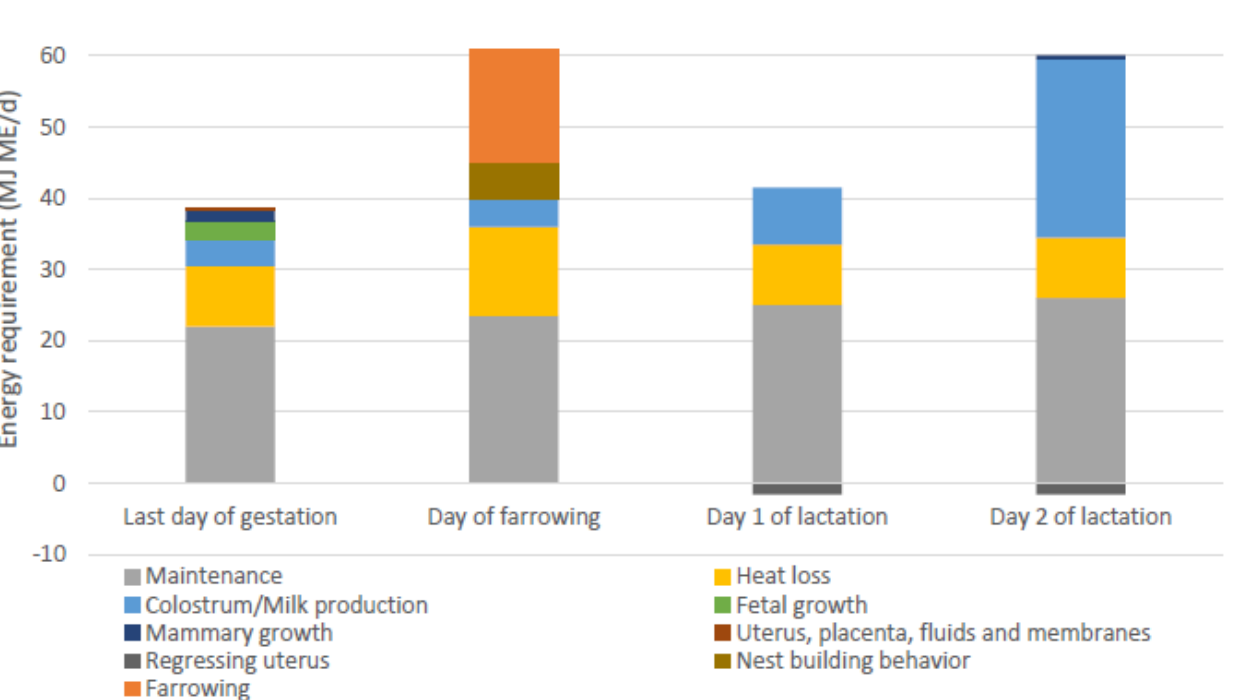
Table 1. Calculation on estimated energy requirements on the day of farrowing per piglet and per 60 min of farrowing based on Che et al. [87] and Feyera et al. [81] .